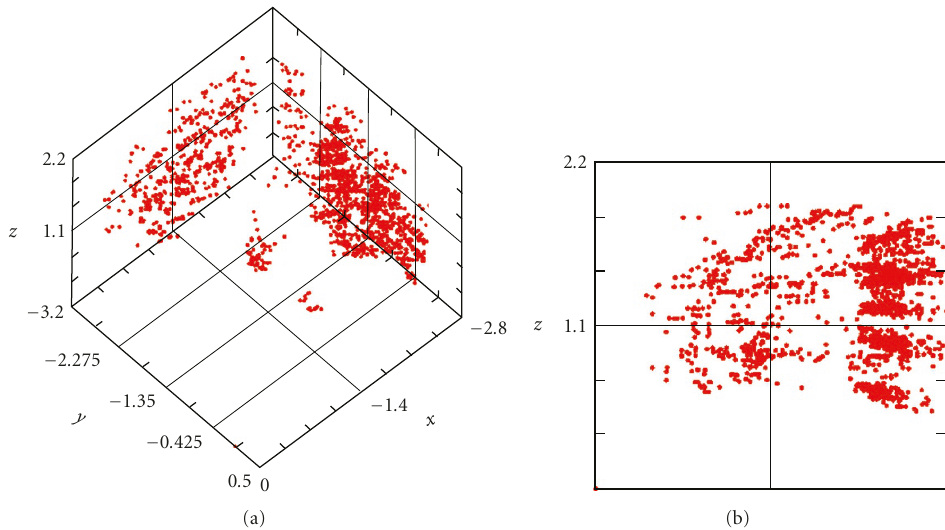
Figure 23: (a) Mapping result using the DP processor. (b) Side view ( x - z plane) of the o ffi ce premises, with the book shelves visible on the right.